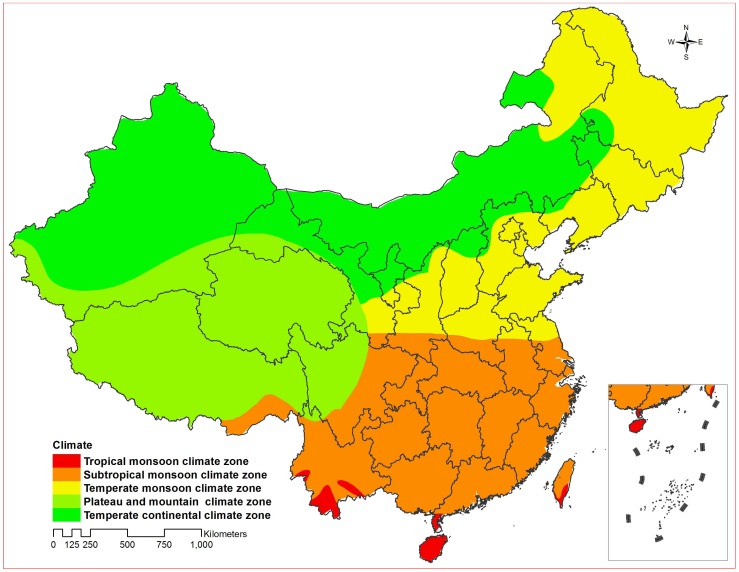
Climate zones in China.